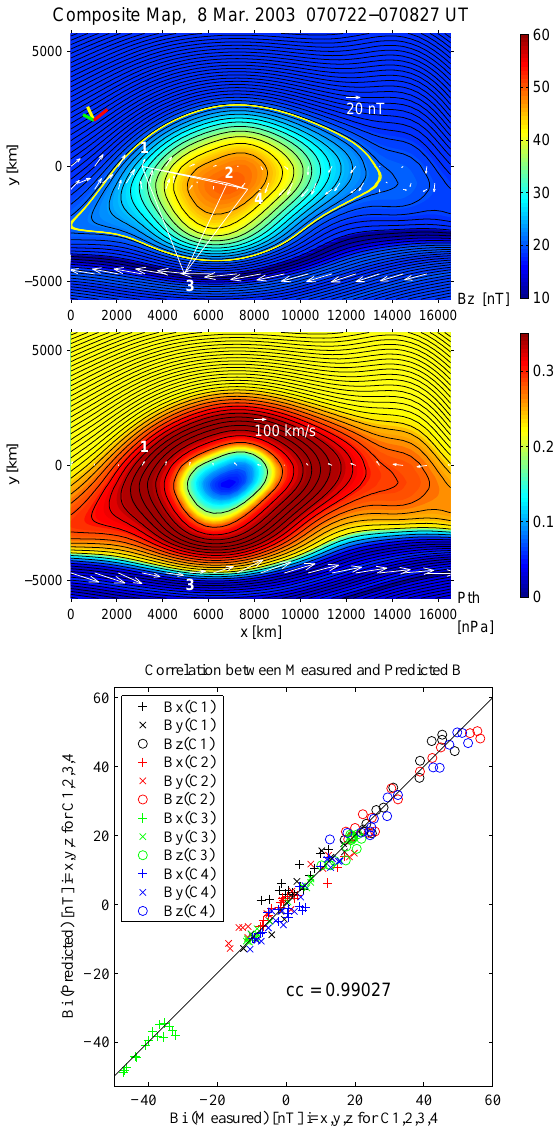
Fig. 3. The top two panels show magnetic field and pressure maps for FTE 2. Reconstructed field lines (in black) are projected onto the plane perpendicular to the invariant (z) axis, with axial field (top panel) or plasma pressure (second panel) in color. In the top panel, Cluster tetrahedron and measured transverse field, B t =( B x , B y ) are shown in white. Colored line segments in the upper-left part are GSE unit vectors, X (red), Y (green), and Z (yellow), projected onto the x – y plane. In the middle panel, white arrows represent mea- sured transverse velocity, transformed into the deHoffmann-Teller frame. The equatorward edge of the map is to the right, with the magnetosphere on the bottom. The bottom panel shows magnetic field components along reconstruction coordinates axes (x, y, z), predicted from the field map, versus those actually measured along the four spacecraft